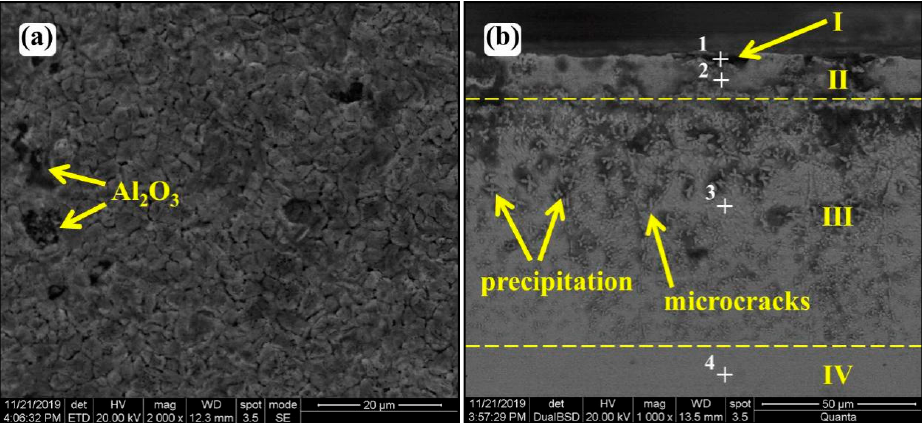
Figure 2. Scanning electron microscopy (SEM) of aluminized 321 stainless steel: ( a ) surface; ( b ) cross- section.